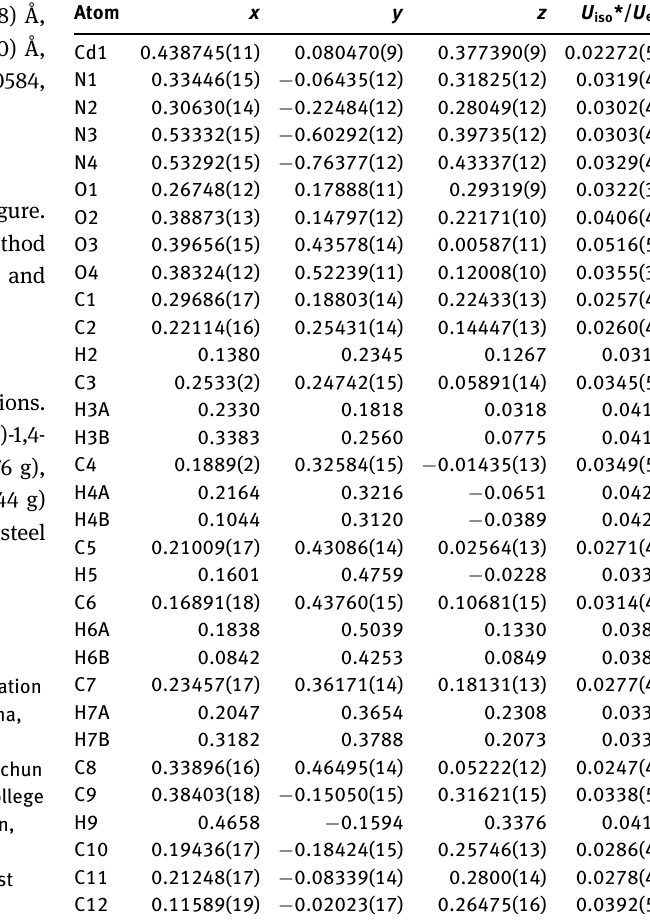
Table 2: Fractional atomic coordinates and isotropic or equivalent isotropic displacement parameters (Å 2